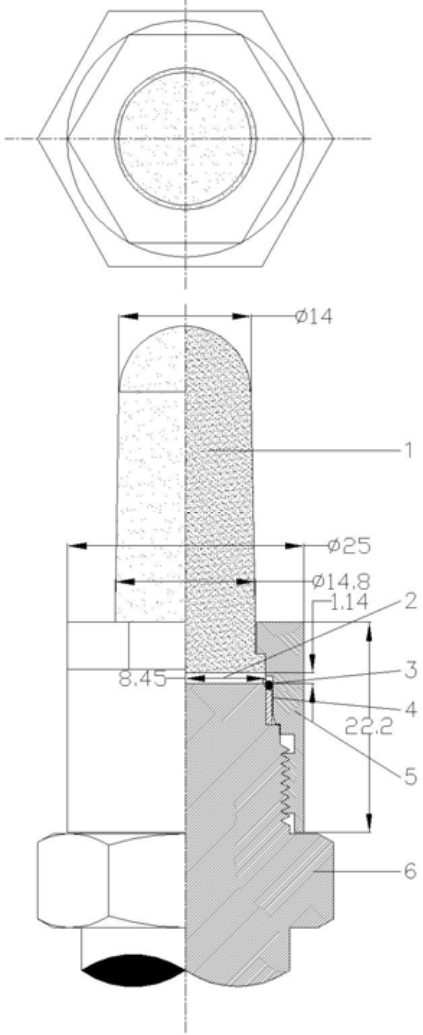
Fig. 1. Polymer tensiometer (POT) design with cone-shaped ce- Figure 1. Polymer tensiometer (POT) design with cone-shaped ceramic containing (1) an 509 ramic containing (1) an α -Al 2 O 3 support layer with a γ -Al 2 O 3 membrane at the base of the cone, (2) polymer chamber, (3) rub- ber O-ring, (4) stainless steel ring, (5) stainless steel mounting ring, O support layer with a γ -Al O membrane at the base of the cone, (2) polymer 510 α -Al and (6) a pressure transducer. Various arrows indicate lengths in 2 3 2 3 mm of components of POT ( ∅ is chamber, (3) rubber O-ring, (4) stainless steel ring, (5) stainless steel mounting ring, and 511 (6) a pressure transducer. Various arrows indicate lengths in mm of components of POT 512 ( ∅ is diameter). 513